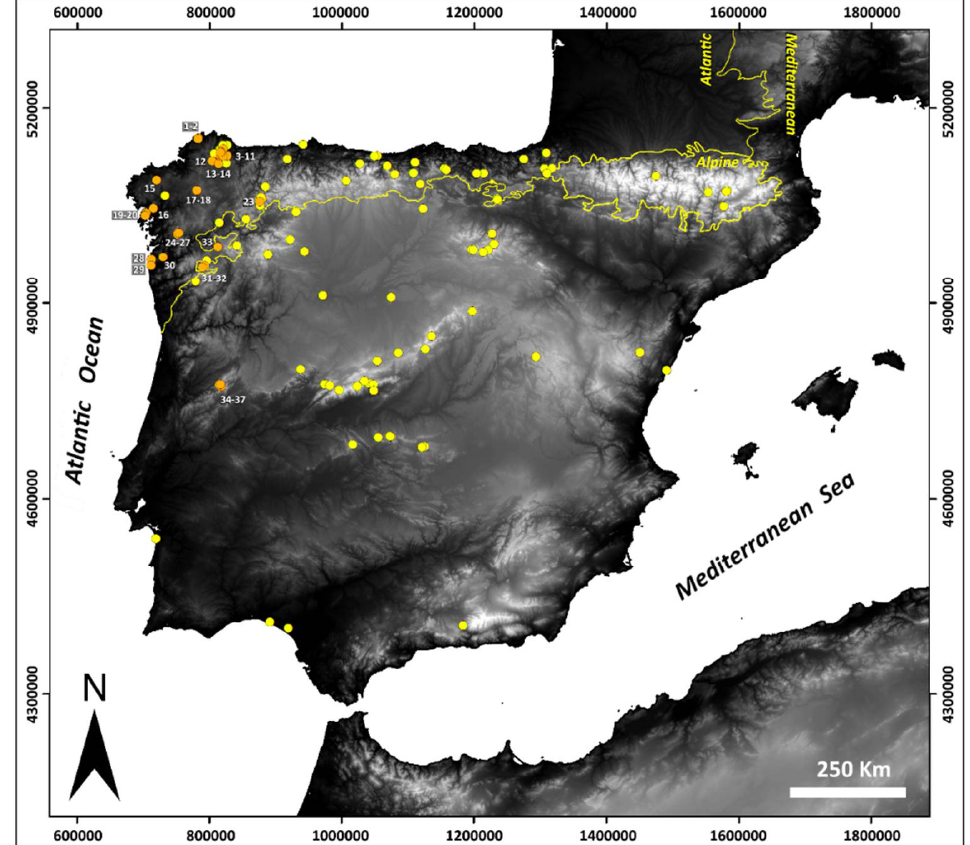
Figure 1. Known peatland ecosystems (yellow) in the Iberian Peninsula (SW Europe) according to Pontevedra-Pombal et al. [10], and locations of the thirty-seven western Iberian peatlands where testate amoeba communities were studied (orange) (Table 1).